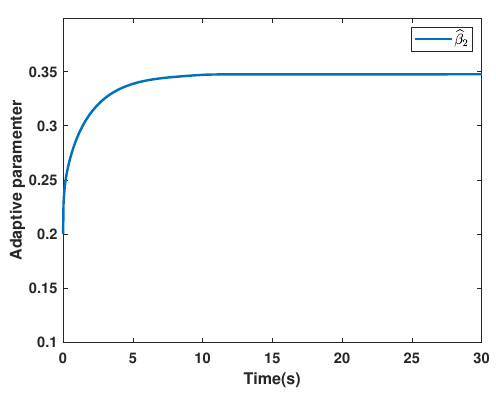
Figure 7. Adaptive parameter (cid:98) β 2 ( t )